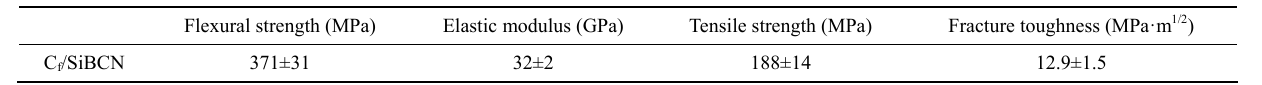
Table 2 Mechanical properties of the C f /SiBCN